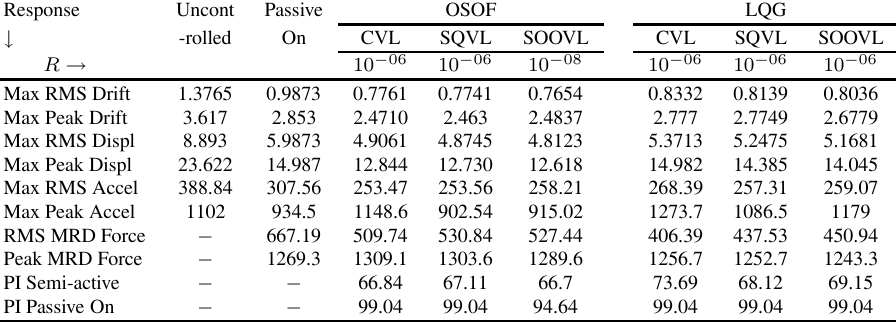
Table 2 Comparison of maximum peak/RMS response, base con fi guration of sensors, one damper, (Drift/Displ -